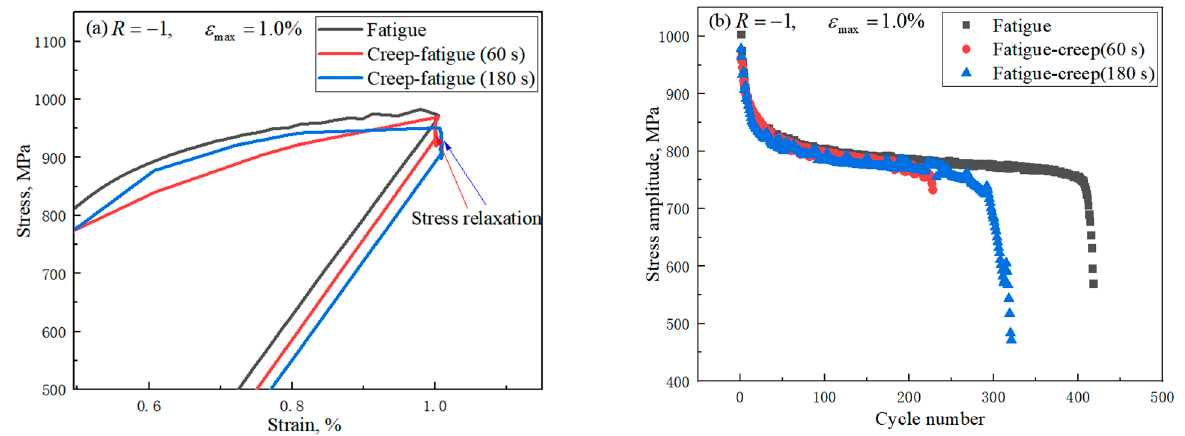
Figure 7. Stress relaxation behavior: ( a ) cyclic curve of stress relaxation at different holding times; ( b ) stress amplitude at different holding times.